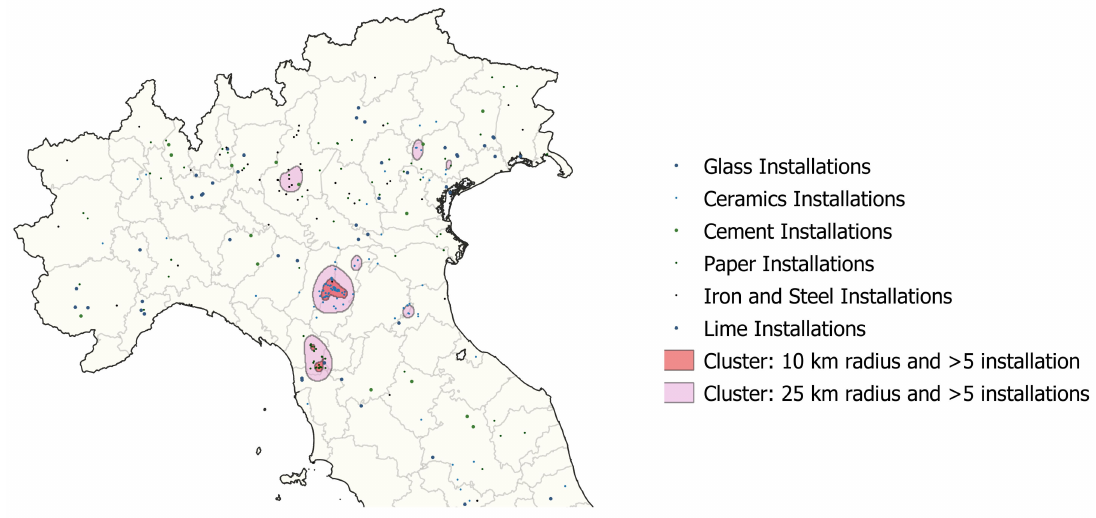
Figure 4. Clusters of industrial installations in Italy according to installation density (minimum installations per cluster is